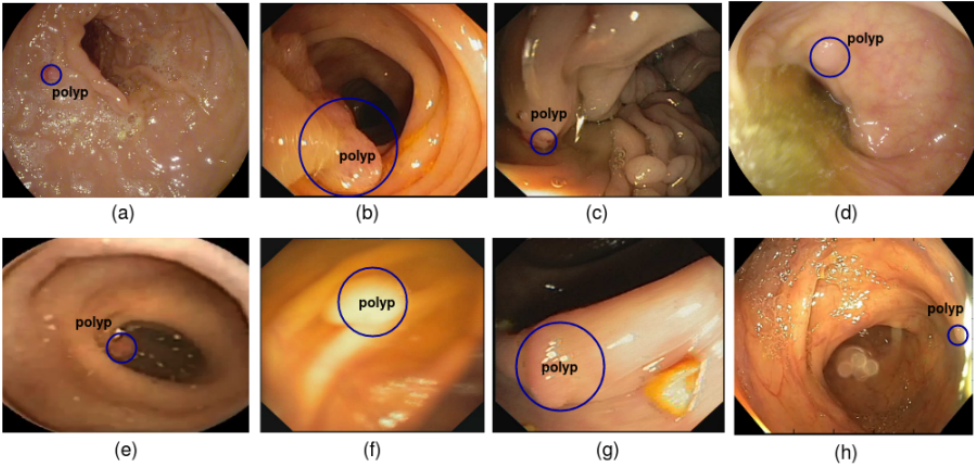
Figure 1. Examples of polyp image artifacts used in the current study. ( a ) Bubbles; ( b ) images with medical instruments; ( c ) white liquid and specular reflections; ( d ) cloudy liquid and specular reflections; ( e ) debris; ( f ) blurry images caused by different factors; ( g ) bile and specularity; ( h ) low contrast between polyp region and normal